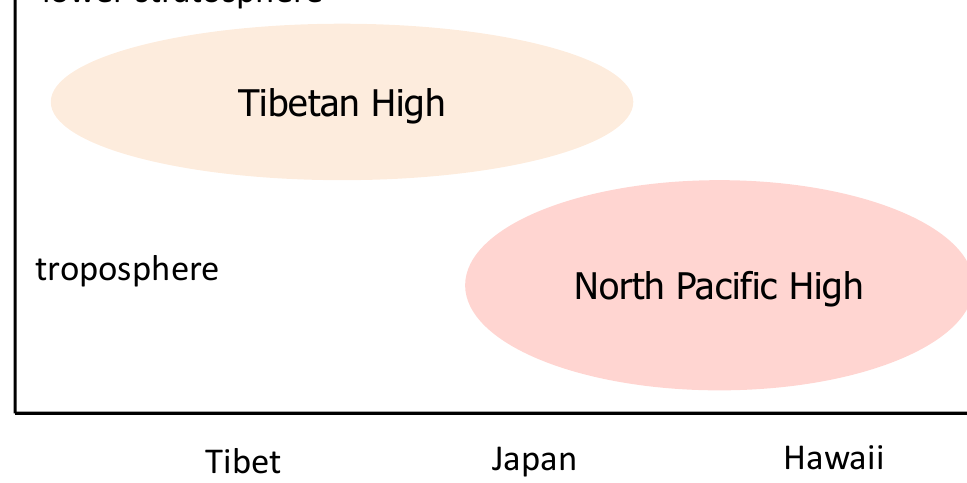
Figure 9. Schematic diagram showing the longitudinal and vertical extensions of the Tibetan High and the North Pacific High during hot summers in Japan. The relationship between the latitudinal direction of extension of the Tibetan High and the region where a hot summer occurs in Japan is summarized in Figure 10a. In hot summer years for the Japanese mainland, high pressure anomalies were seen at 150 hPa over Japan. This means that hot summer in the mainland occurs due to extension to the north (i.e., the Japanese mainland) of the Tibetan High (Figure 10a). By contrast, extension to the south can lead to drought in the Southwestern Islands. Next, we focus on extension of the North Pacific High in the troposphere (Figure 10b). In hot summer years for Northern Japan, high pressure anomalies at 500 hPa are observed in the Japanese islands. On the other hand, hot summer in the Southwestern Islands seems to occur with high pressure anomalies in the subtropical zone including the southern part of Japan. This might mean that the North Pacific High extends to the north during hot summers in the Japanese mainland, whereas hot summers in the Southwestern Islands occur due to extension to the south of the North Pacific High (Figure 10b). In other words, the summer climate in each region of Japan is profoundly controlled by the direction of extension of these two